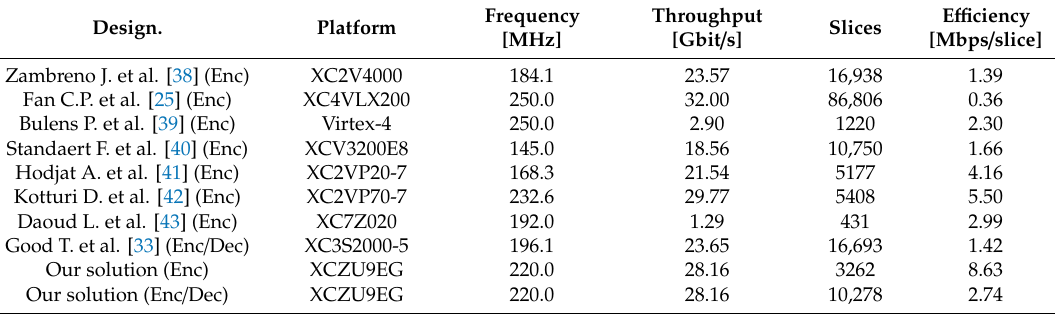
Table 4. Comparison of the proposed AES-128 solution with other FPGA implementations. Design.